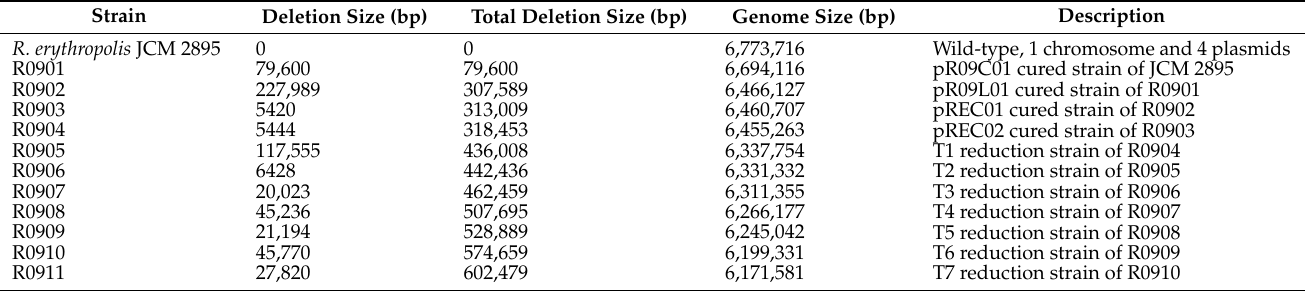
Table 1. Deletion size and genome size of wild and mutant strains of R. erythropolis JCM 2895.